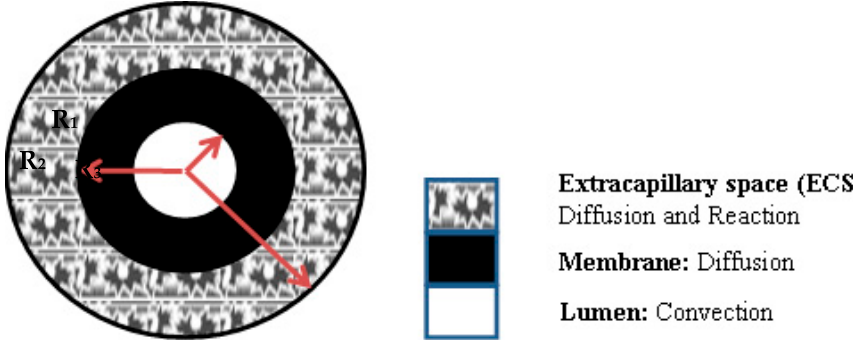
Figure 3. A single hollow fibre defined as a Krogh cylinder indicating the dominant nutrient transport mechanism.